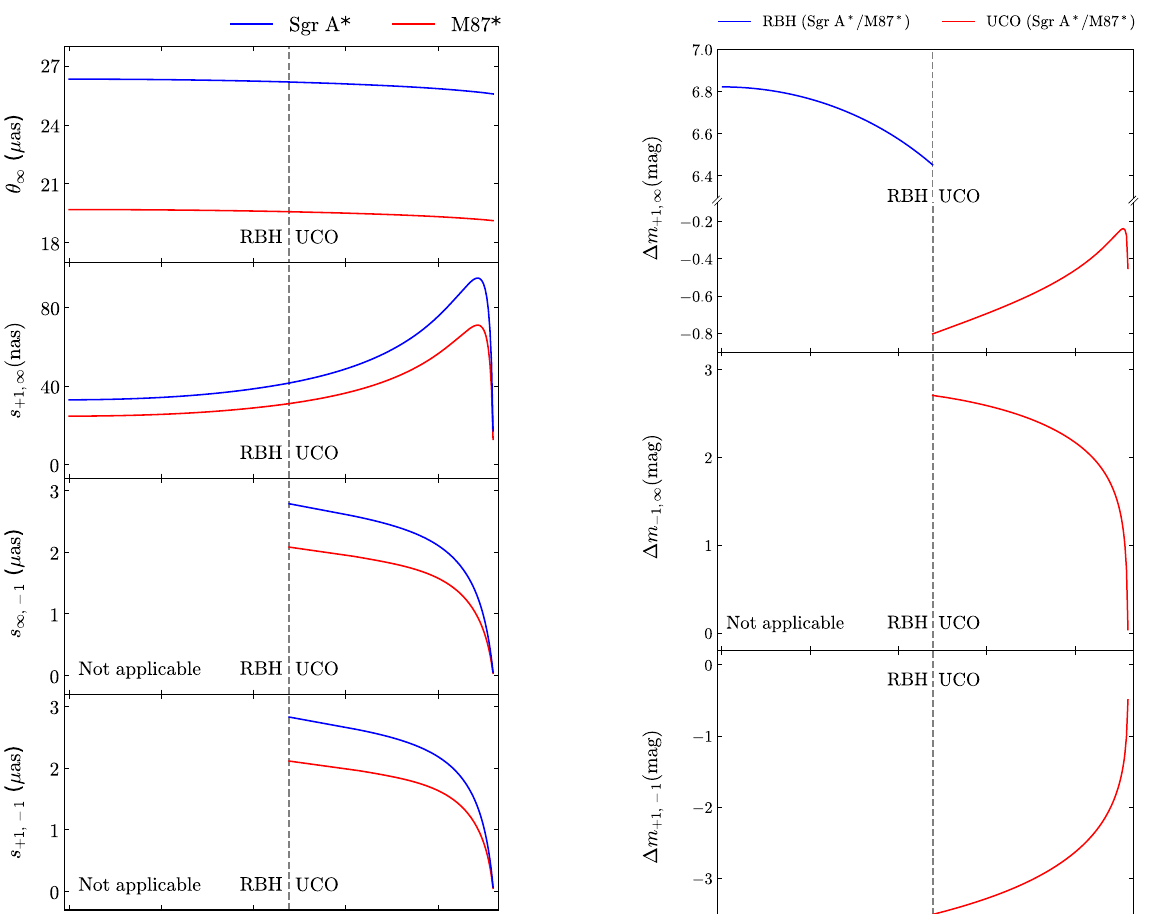
same shape since their difference s + 1 , − 1 − s ∞ , − 1 = s + 1 , ∞ is significantly less than both of them. For Sgr A*, s ∞ , − 1 and s + 1 , − 1 reduce from about 2.8 µ as to about 0.8 µ as;